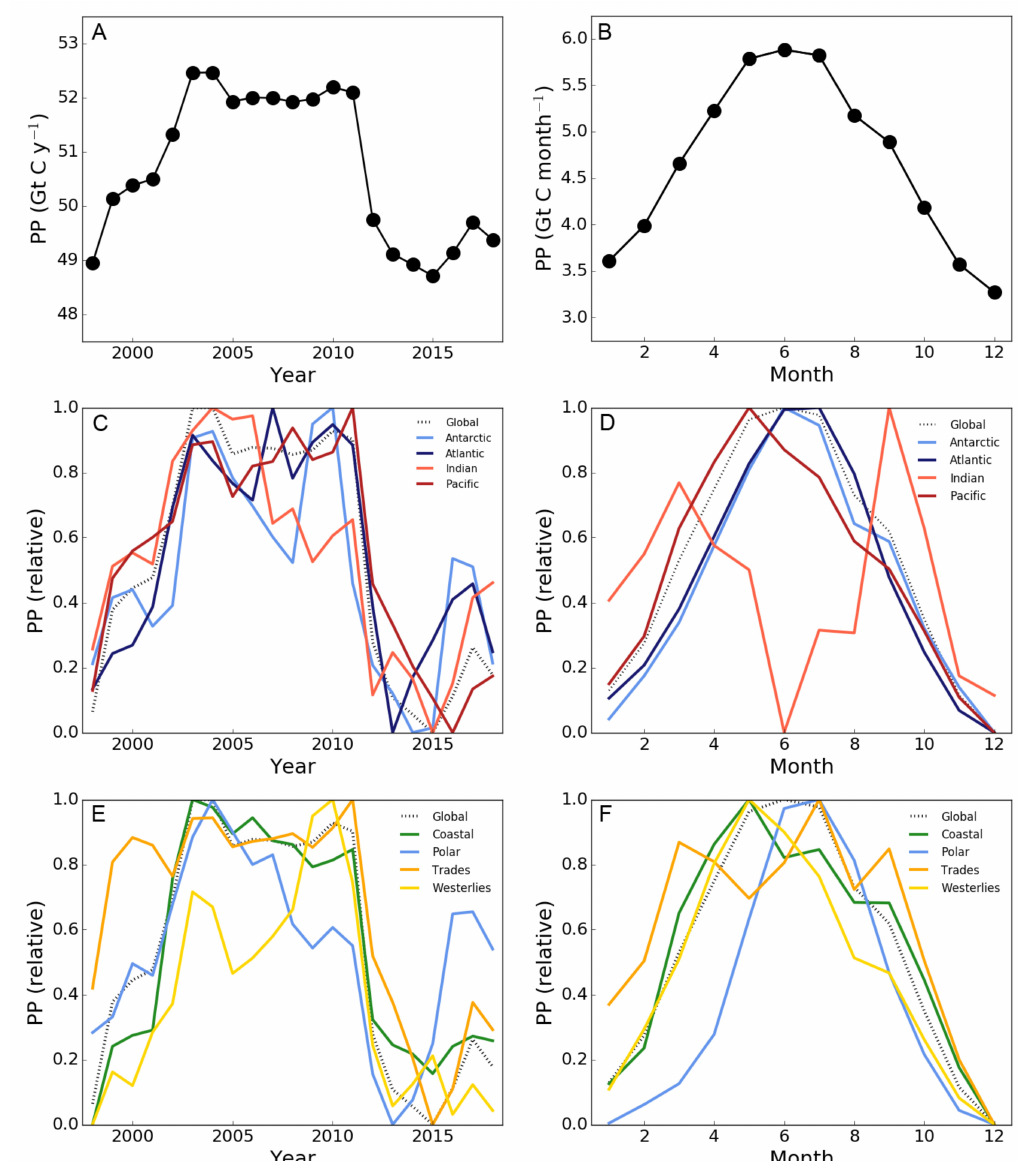
Figure 4. Trends in primary production (PP) with ( A ) annual global primary production for each year in the period between 1998 and 2018, ( B ) mean monthly primary production, ( C ) relative annual and ( D ) monthly primary production for each oceanic basin and ( E ) relative annual and ( F ) monthly primary production for each biome as defined by Longhurst (2007). The dotted lines illustrate the relative global primary production per year ( C , E ) and month ( D , F ). Estimates of monthly primary production for the Southern Hemisphere were shifted to depict the summer season (December–February) along with that of the Northern Hemisphere (June–August) in months 6–8. Relative trends for each basin and biome were calculated by subtracting the minimum primary production from the annual ( C , E ) or monthly ( D , F ) primary production and dividing this by the difference between the minimum and maximum primary production between 1998 and 2018 or between January and